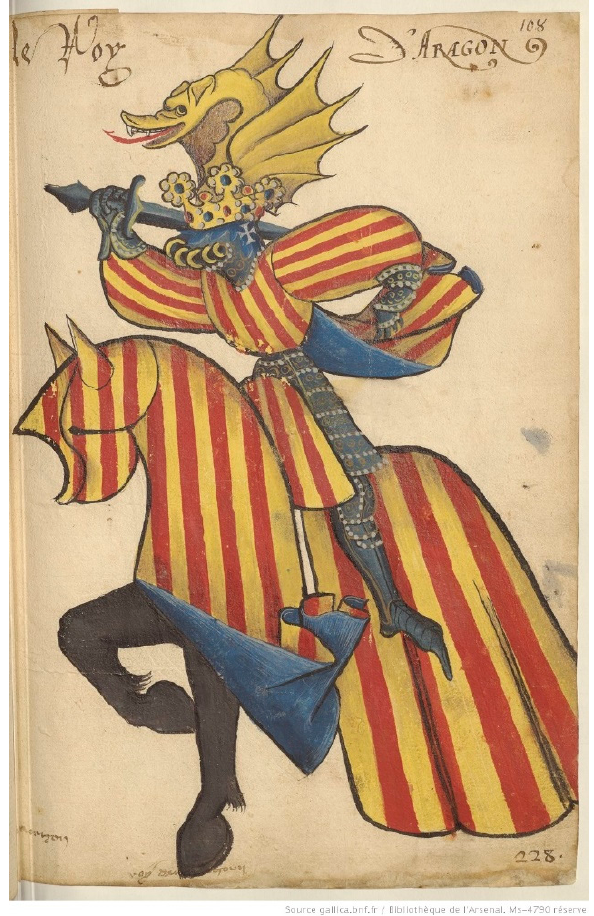
Figure 10. The King of Aragon, Armorial de l’Europe et de la Toison d’or, Paris, Bibliothèque de l’Arsenal, Ms 4790 f. 108r. Used by permission.